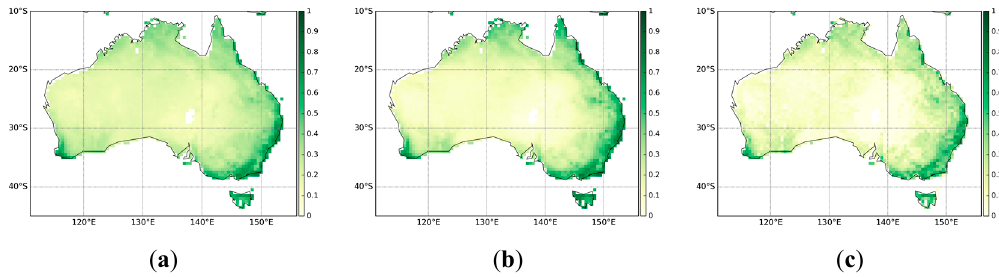
Figure 2. Spatial patterns of monthly mean average Fraction of Absorbed Photosynthetically Active Radiation (FAPAR) for the years 2001–2015: ( a ) Moderate Resolution Imaging Spectroradiometer (MODIS), ( b ) COPERNICUS Global Land Service (CGLS), ( c ) Quality Assurance for Essential Climate Variables (QA4ECV).